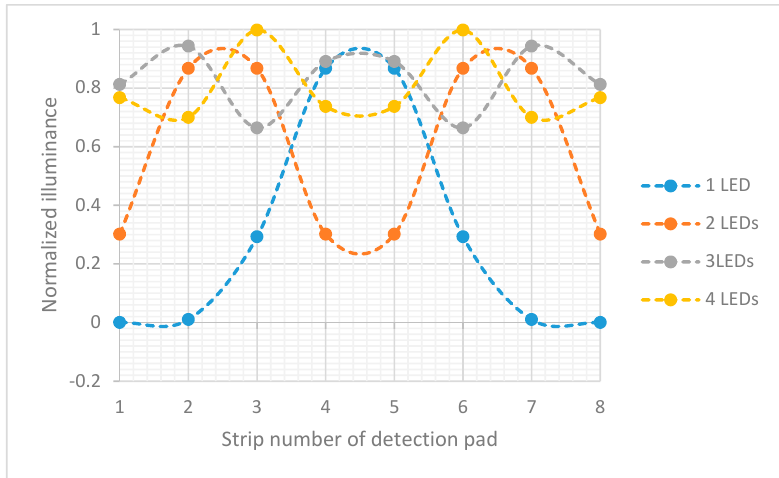
Figure 3. Normalized illuminance in each of eight 1 mm detection pad strips when the illumination is performed by varying the number of LEDs from one to four.